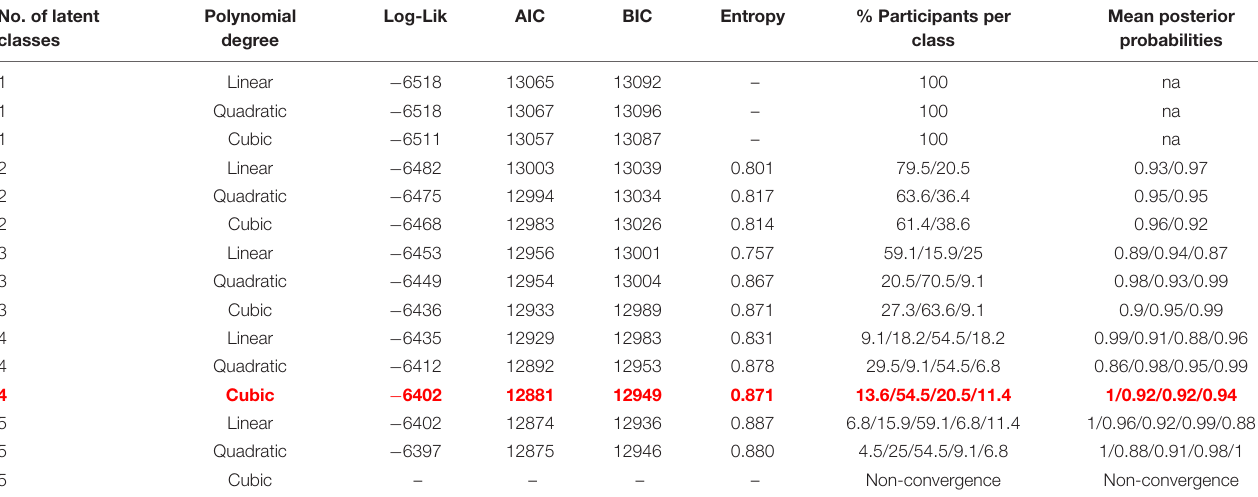
TABLE 3 | Latent class mixed model (lcmm) results of the model fitting process for TMD, NA, and LLMS. No. of latent classes